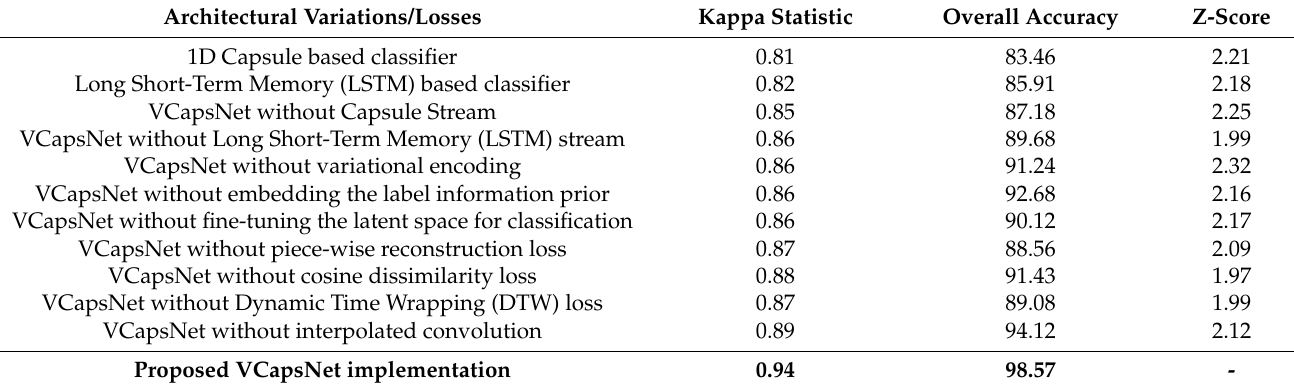
Table 1. Analysis of the effect of the proposed architectures and constraints for 50% of the training samples *.